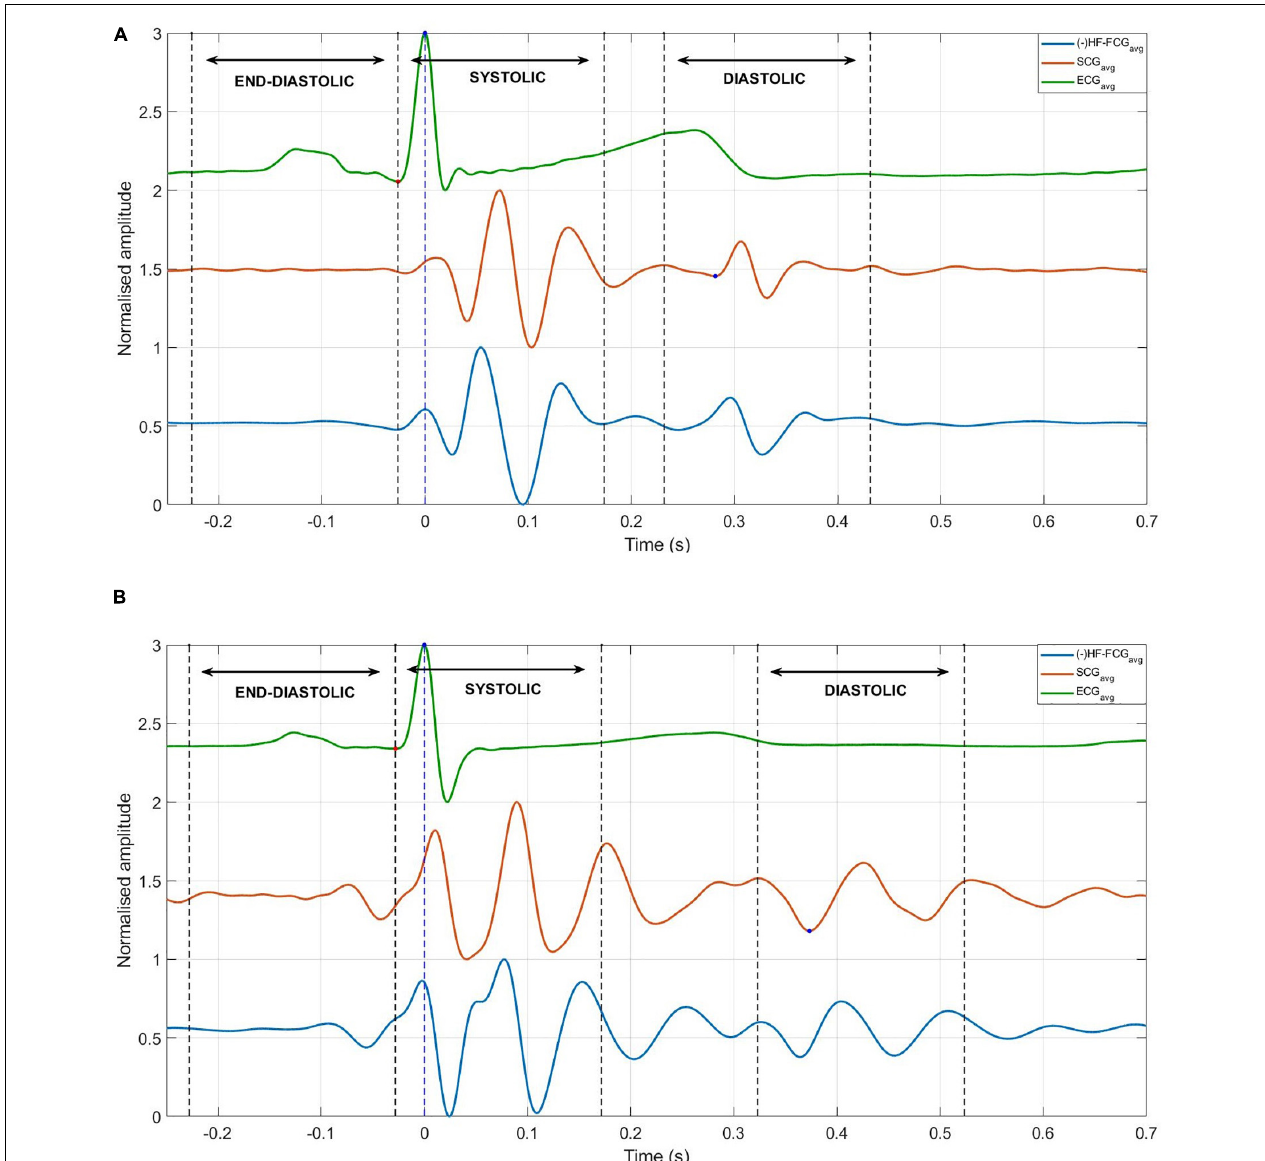
FIGURE 12 | Ensemble averages of HF-FCG, SCG, and ECG, with boundaries of systolic, diastolic, and end-diastolic intervals (dashed lines). (A) Example of signals with no significant components in the end-diastolic interval, which scored low correlation indices in the same interval. (B) Example of signals with significant components in the end-diastolic interval, which scored high correlation coefficients in the same